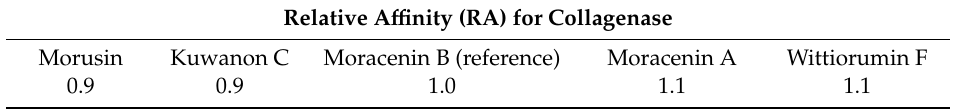
Table 2. Evaluation of collagenase inhibitory activity of N- extract and its prenylated compounds in comparison to a commercial extract of Morus alba L. roots using UHPLC technique.